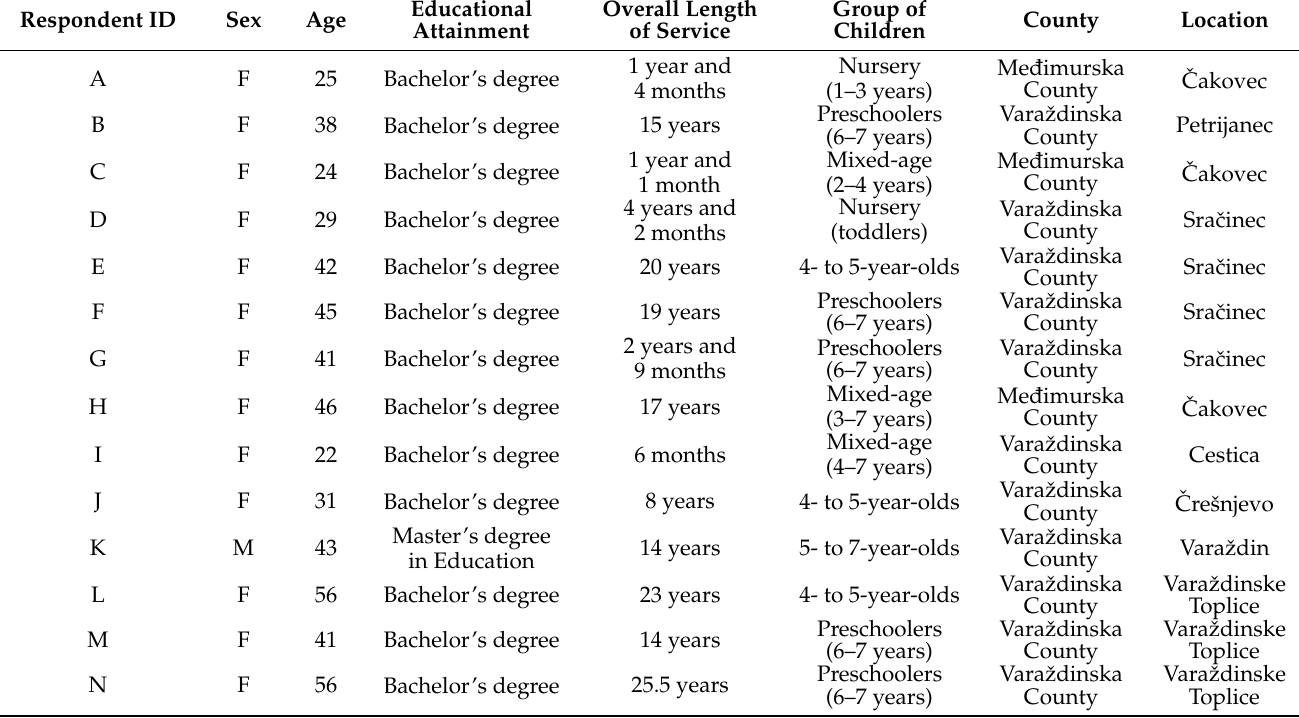
Table 1. Demographic profile of the childcare professionals included in the